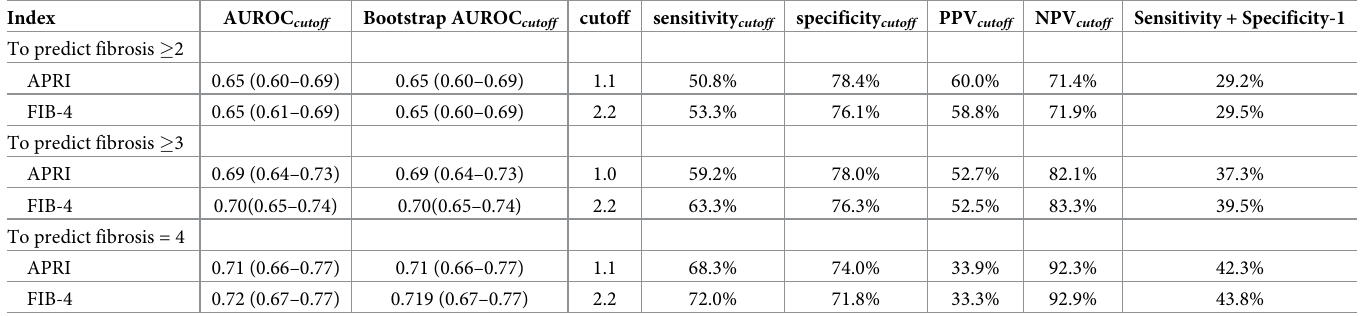
Diagnostic accuracies of APRI and FIB-4 for predicting liver fibrosis in patients with 37 < AST (cid:20) 74 IU/L The bootstrap AUROCs of APRI and FIB-4 for the diagnosis of (cid:21) F2, (cid:21) F3, and F4 were 0.65 and 0.65, 0.69 and 0.70, and 0.71 and 0.72, respectively, in patients with 37 < AST (cid:20) 74 IU/L. The optimal cutoff values of APRI and FIB-4 for the diagnosis of (cid:21) F2, (cid:21) F3, and F4 were 1.1 and 2.2, 2.2 and 1.0, and 1.1 and 2.2, respectively, in patients with 37 < AST (cid:20) 74 IU/L (Table 4). Diagnostic accuracies of APRI and FIB-4 for predicting liver fibrosis in patients with 74 < AST (cid:20) 148 IU/L The bootstrap AUROCs of APRI and FIB-4 for the diagnosis of (cid:21) F2, (cid:21) F3, and F4 were 0.66 and 0.69, 0.69 and 0.71, and 0.72 and 0.73, respectively, in patients with 74 < AST (cid:20) 148 IU/L. The optimal cutoff values of APRI and FIB-4 for the diagnosis of (cid:21) F2, (cid:21) F3, and F4 were 1.9 and 3.0, 2.2 and 3.2, and 2.2 and 3.4, respectively, in patients with 74 < AST (cid:20) 148 IU/L (Table 5). Diagnostic accuracies of APRI and FIB-4 for predicting liver fibrosis in patients with AST > 148 IU/L The bootstrap AUROCs of APRI and FIB-4 for the diagnosis of (cid:21) F2, (cid:21) F3, and F4 were 0.68 and 0.68, 0.68 and 0.70, and 0.68 and 0.70, respectively, in patients with AST > 148 IU/L. The Table 4. Diagnostic accuracies of APRI and FIB-4 for predicting liver fibrosis (37 < AST (cid:20) 74, N = 501). Index AUROC